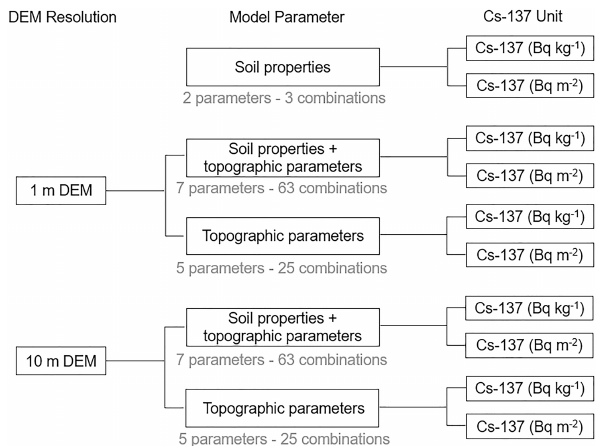
Figure 9. GAM parameter